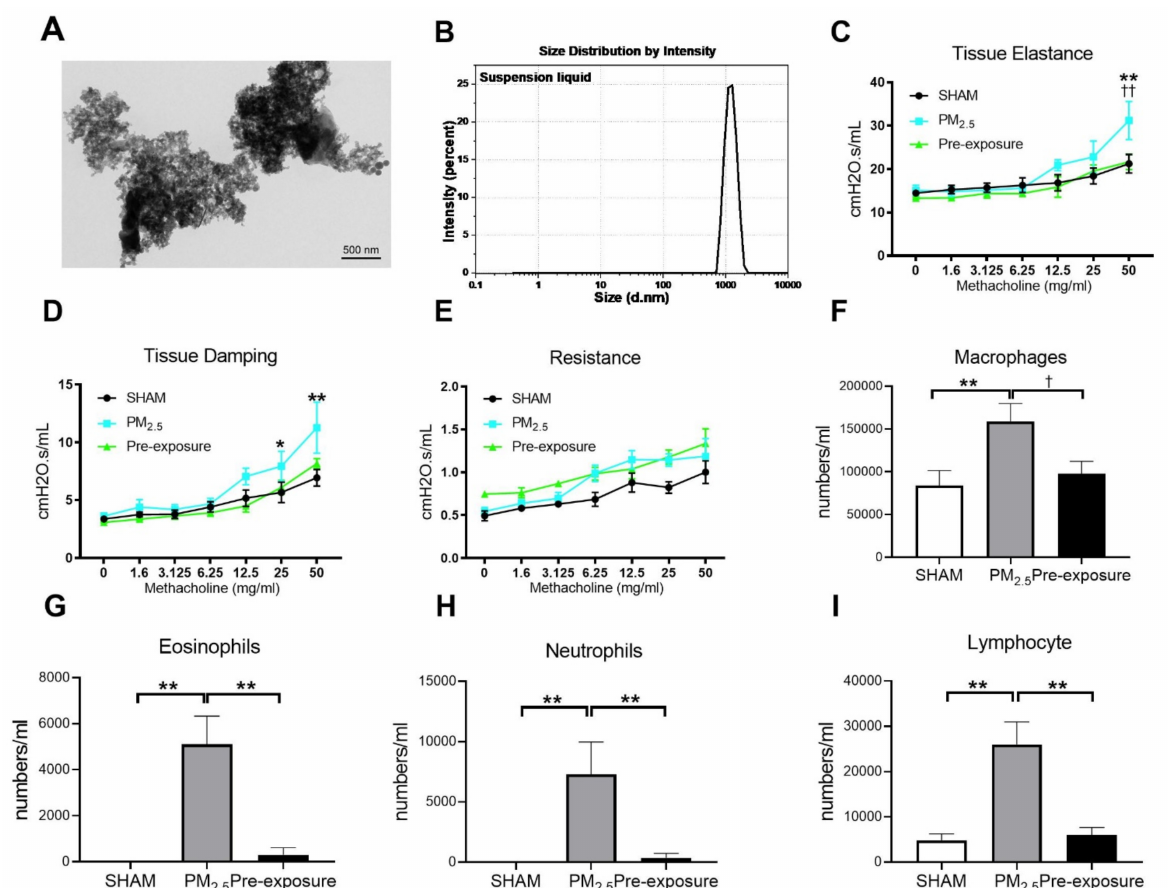
Figure 2. TEM images of PM 2.5 configuration, body weight, lung function and leukocytes numbers in the dams. Charac- terisation of the TRAP PM by ( A ) TEM and ( B ) dynamic light scattering. Lung function parameters: ( C ) tissue elastance, ( D ) tissue damping and ( E ) resistance from dams exposed to TRAP PM; the number of ( F ) macrophages, ( G ) eosinophils, ( H ) neutrophils and ( I ) lymphocytes in the dams. Results are expressed as means ± SEM. Data were analysed by one-way ANOVA followed by Fisher’s LSD post hoc tests. Lung function was analysed by the two-stage linear step-up procedure of Benjamini, Krieger, and Yekutieli, followed by controlling the False Discovery Rate. n = 8. In ( C , D ) * p < 0.05, ** p < 0.01, SHAM vs. PM 2.5 . †† p < 0.01, PM 2.5 vs. Pre-exposure; in ( F – I ), * p < 0.05, ** p < 0.01, † p < 0.05. PM 2.5 : dams exposed to PM 2.5 (5 µ g/day) prior to mating for 6 weeks during gestation and lactation. Pre-exposure: dams exposed to PM 2.5 for only 6 weeks prior to